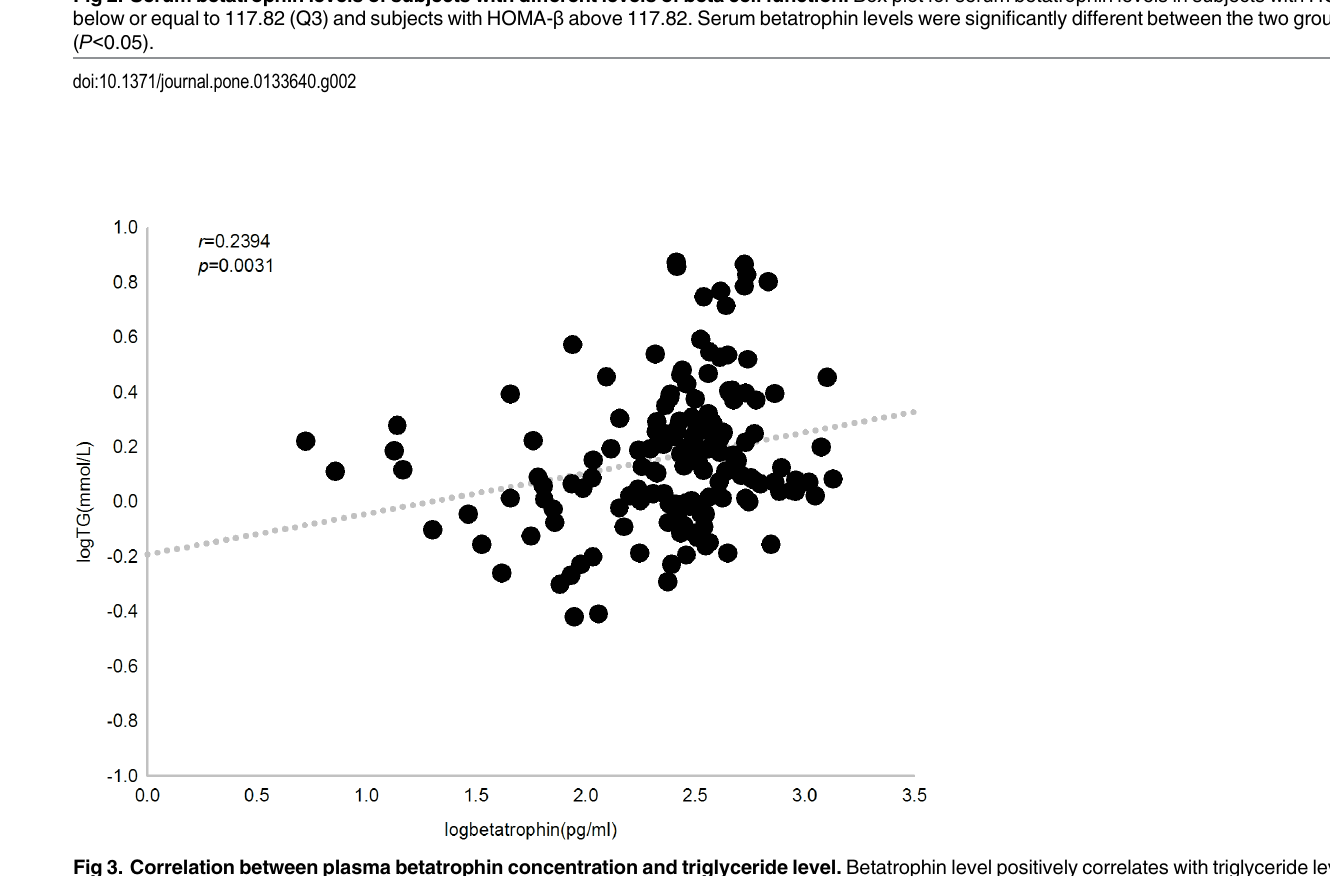
Fig 3. Correlation between plasma betatrophin concentration and triglyceride level. Betatrophin level positively correlates with triglyceride level in all subjects ( r = 0.239, P =